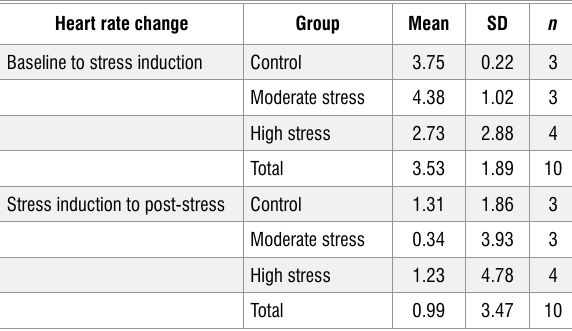
Descriptive statistics for heart rate